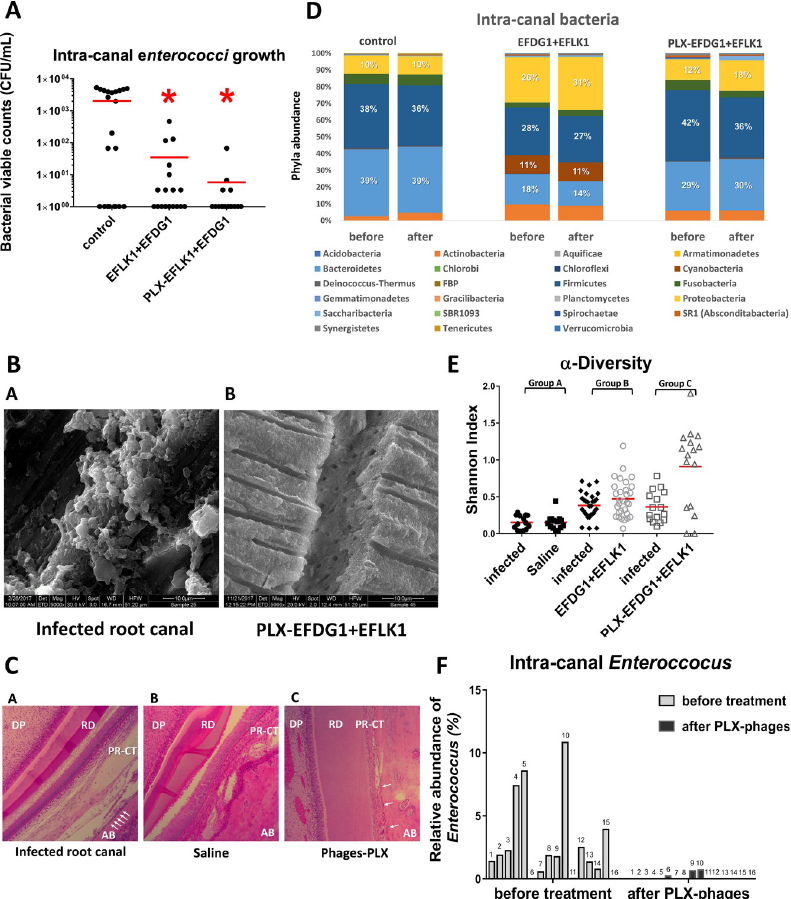
Fig 6. Phage treatment against VRE periapical infection in rats. (A) Intracanal viable enterococci counts after treatment with EFDG1/EFLK1 phage suspension and EFDG1/EFLK1 poloxamer-phage formulation. Viable counts of enterococci show a significant decrease following phage treatment. Control = saline irrigation, EFLK1 +EFDG1 = EFDG1/EFLK1 phage suspension irrigation (10 9 PFU/mL), PLX-EFLK1+EFDG1 = EFDG1/EFLK1 poloxamer-phage formulation (10 9 PFU/mL). Statistical significance was calculated by Student’s t-test (significance level: p < 0.05) compared to the untreated control (n = 14–16 teeth in every tested group). (B) Scanning electron microscopy: no survival of bacteria in rat dentinal tubules. (magnification: X5000) [A] control: E . faecalis -infected tooth shows biofilm inside the dentinal tubules; [B] E . faecalis -infected tooth treated by poloxamer-phage formulation does not exhibit bacteria inside the dentinal tubules. (C) Histology of E . faecalis- infected rat incisors followed by root canal treatment with poloxamer-phage formulation showing reduced inflammation. Histology of sagittal cross-sections of the periapical area of Wistar rat incisors that were decalcified, and H&E stained. [A] E . faecalis- infected teeth show enlarged peri-radicular connective tissue and osteoclasts suggesting inflammation, bone resorption and apical periodontitis. [B] E . faecalis- infected teeth that were irrigated with saline show enlarged highly cellular peri- radicular connective tissue and necrosis. Osteoclasts are present in the alveolar bone. [C] E . faecalis- infected tooth that was treated with poloxamer-phage formulation shows highly vascularized dental pulp, reduced peri-radicular connective tissue, and a woven bone with osteoclast presence. White arrows indicate infiltration of osteoclasts. DP = dental pulp. RD = root dentin. PR-CT = peri-radicular connective tissue. AB = alveolar bone (magnification: × 10). (D) Changes of the relative abundance of intracanal phyla due to root canal treatments. The changes in the intracanal microbiota were evaluated using 16S genome sequencing. Intracanal samples were collected 4 weeks after E . faecalis infection (before treatment) and 3 weeks after root canal treatment. Root canal treatment included instrumentation and treatment with one of the following: group A: Saline irrigation; group B: EFDG1/EFLK1 phage cocktail irrigation (10 9 PFU/mL); or group C: EFDG1/EFLK1 poloxamer-phage formulation (10 9 PFU/mL). The most abundant phyla were Firmicutes , Bacteroidetes and Proteobacteria . Phage cocktail suspension and poloxamer-phage formulation treatments caused a decrease in the relative abundance of Firmicutes and an increase in the relative abundance of Proteobacteria . (n = 14–16). (E) Alpha diversity dot plot representing taxa richness changes before and after root canal treatment (Shannon index) and differences between the treatment groups. Standard root canal treatment with instrumentation and group A: saline irrigation; group B: EFDG1/EFLK1 phage cocktail irrigation (10 9 PFU/mL); or group C: EFDG1/EFLK1 poloxamer-phage formulation (10 9 PFU/mL). Higher values of alpha